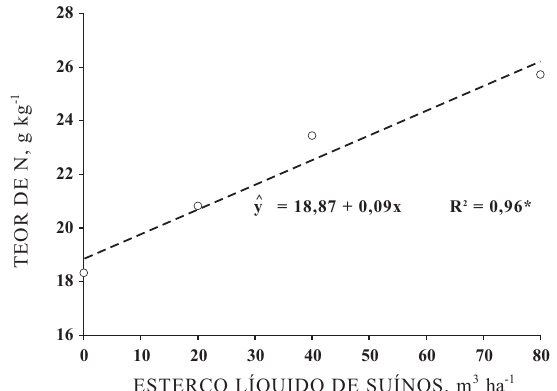
Figura 2. Teores de N da cobertura vegetal da mistura forrageira de aveia mais azevém, determinados aos 156 DAE (3 o corte), em função das doses de esterco líquido de